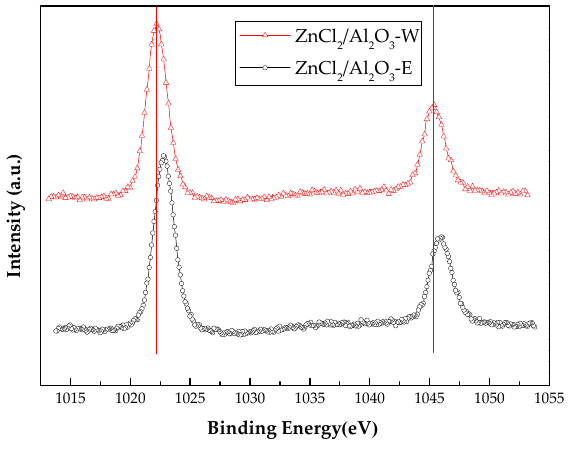
Figure 6. XPS spectra of Zn 2p in ZnCl 2 /Al 2 O 3 ‐ E and ZnCl 2 /Al 2 O 3 ‐ W. Table 4. Binding energies of Zn 2p 1/2 and Zn 2p 3/2 of pure zinc species and zinc chloride modified alumina. XPS Peaks